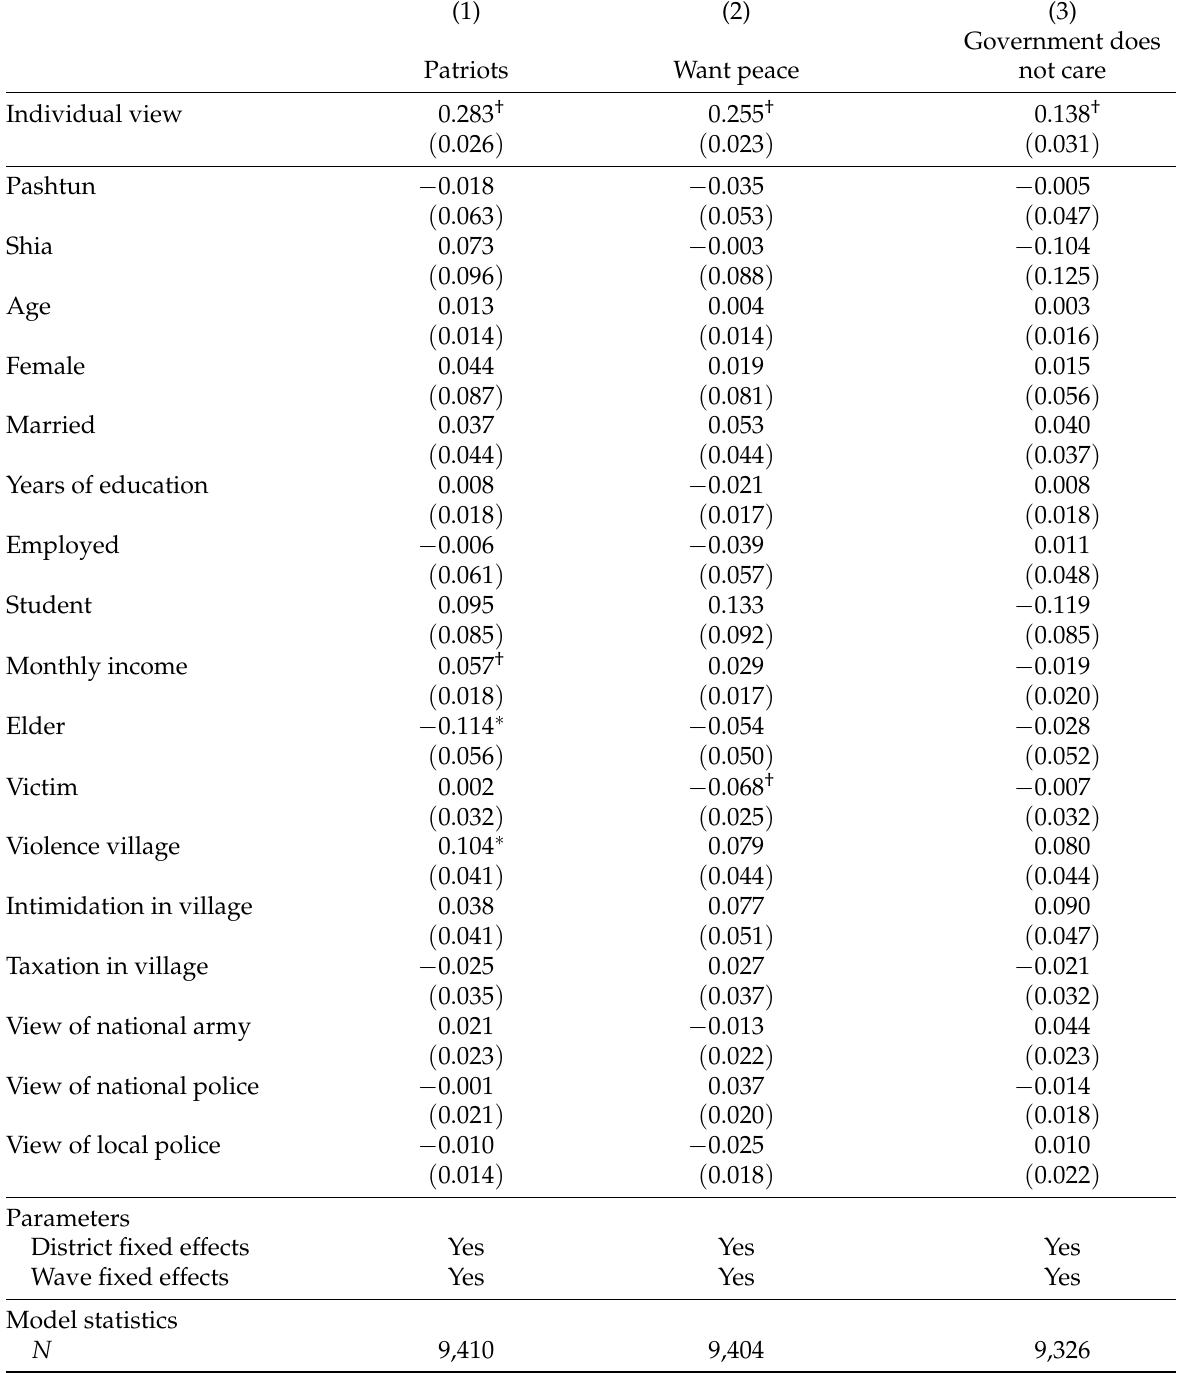
Table 6: Association between main measure of Taliban support and individual’s indirect assessment of Taliban